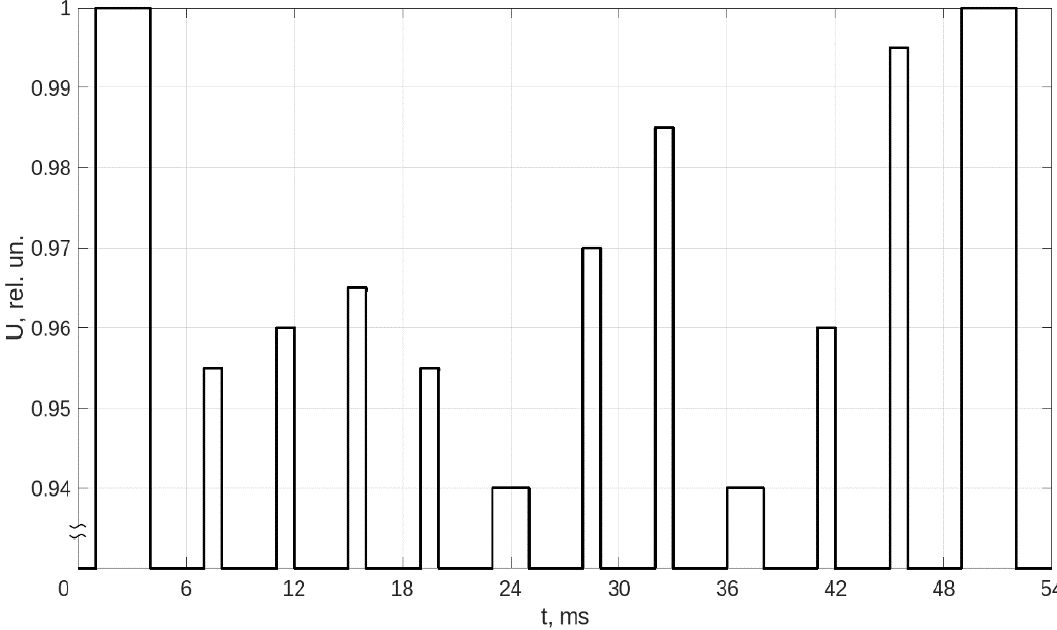
Figure 2. A sequence of command codes in the form of rectangular pulses for transmitting a confir- mation command in analog form via FOCL.